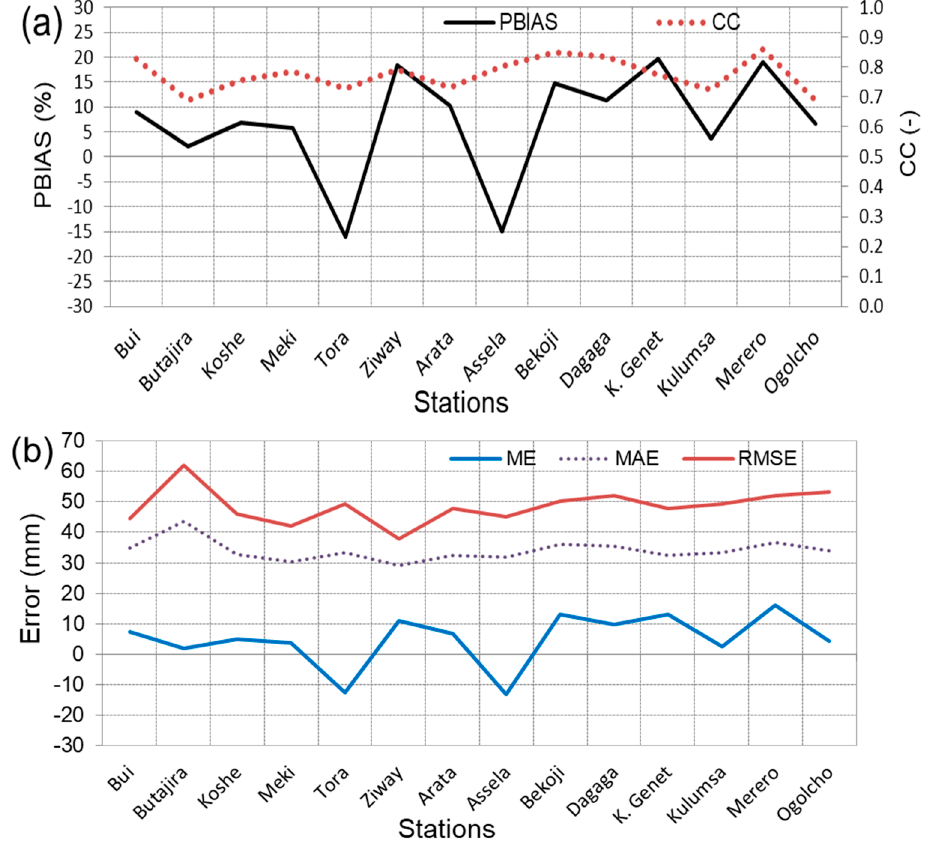
Figure 3. Monthly comparison of CHIRP rainfall estimate against 14 rain gauge stations time series from 1985–2000 ( a ) PBIAS and CC; ( b ) error (ME, MAE, and RMSE).